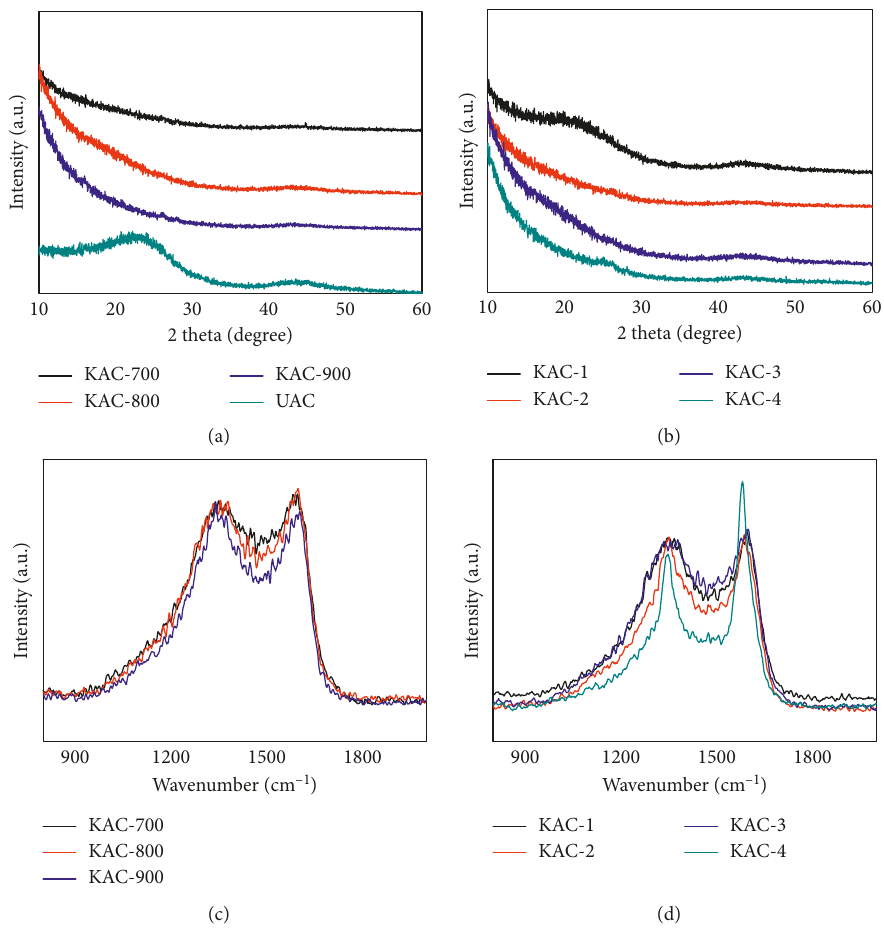
Figure 2: XRD patterns of KAC materials activated under (a) different temperatures and (b) different KOH/C ratios in comparison with UAC, (c) and (d) Raman spectra of KAC-based